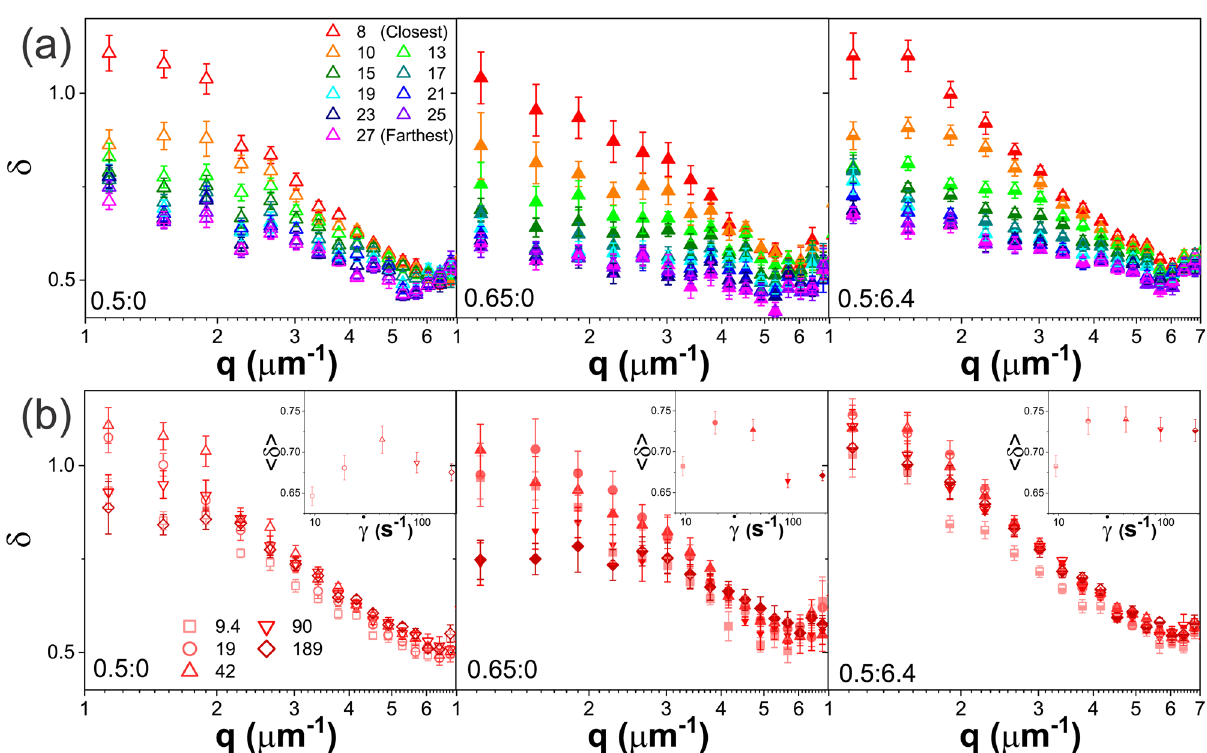
Fig.5|Scalingexponents δ indicateactiveDNAtransportandcon fi nedmotion near and far from the strain. a DDM derived exponential scaling exponents δ (describedintext)versuswavevector q forvaryingdistancesfromthe strain, listed in μ m and color-coded from warm to cool colors for increasing y , for 0.5:0 (left, open symbols), 0.65:0 (middle, fi lled symbols) and 0.5:6.4 (right, half- fi lled sym- bols) subjectto _ γ =42s − 1 straining. 0.65:0 exhibits the strongest y dependenceand lowest values of δ . b δ ð q Þ for y =8 μ m (red, closest to the strain) and varying strain rates _ γ , listed in s − 1 and delineated by different symbols and a color gradient from